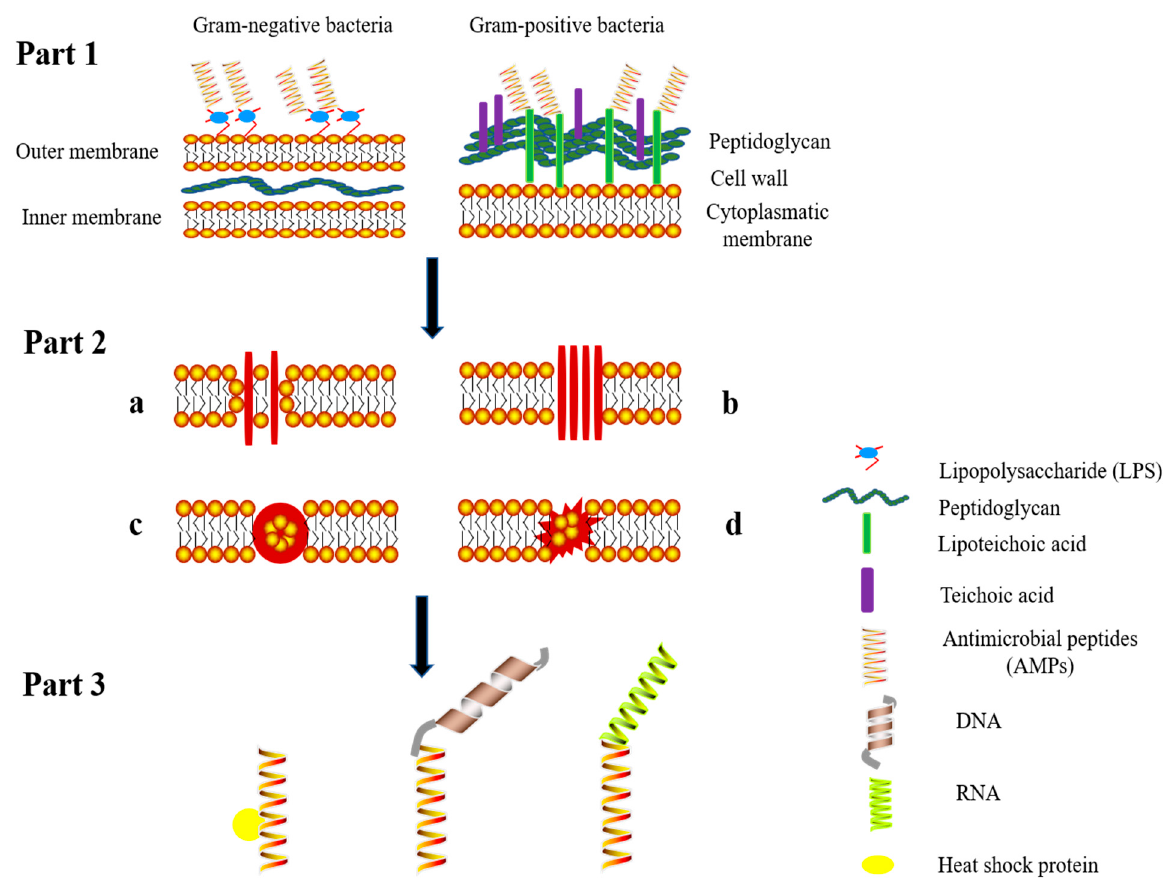
Figure 1. Mechanism of action of antimicrobial peptides on bacterial cells. This figure presents a scheme of the models of action of AMPs: binding to the bacterial cell membrane (Part 1), possible effect resulting in the destruction of bacterial cell membrane (Part 2) and interactions of AMPs with intracellular substances (Part 3). Part 1: AMPs bind to lipopolysaccharides (LPS) of Gram-negative bacteria and to lipoteichoic or teichoic acid of Gram-positive bacteria and penetrate the cell wall. Part 2: Then the AMPs destroy the membrane structure via four pathways ( a ) toroidal model, ( b ) carpet-like model, ( c ) barrel-stave model, and ( d ) unstructured ring pores. Part 3: antibacterial activity of AMPs is mediated by interactions with heat shock proteins, DNA and RNA.